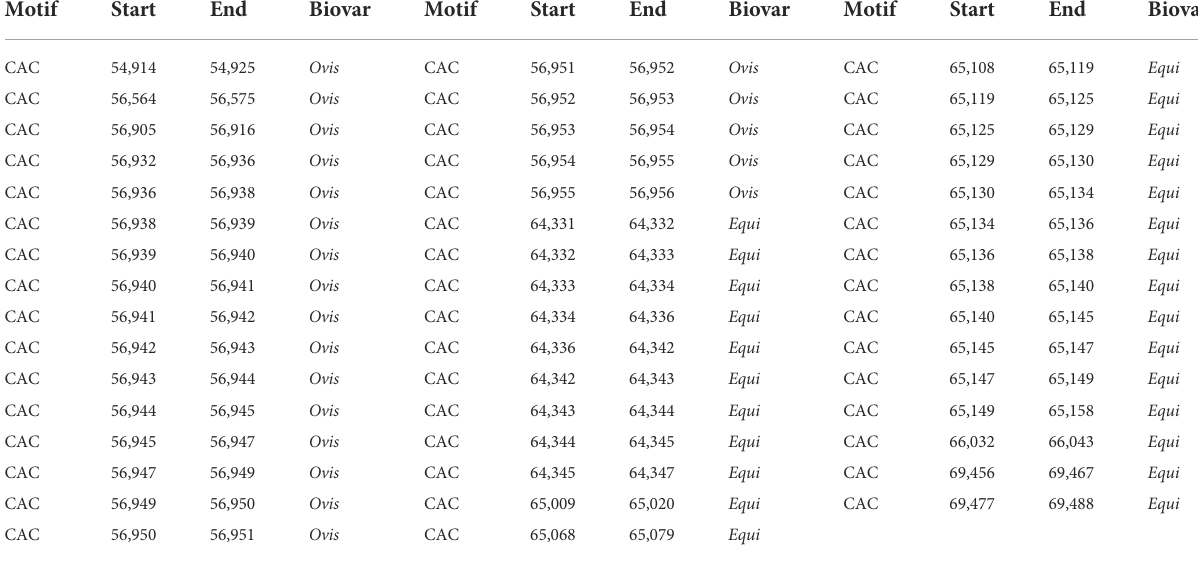
TABLE 3 Localization of the CAC motif between equi and ovis biovars. Motif